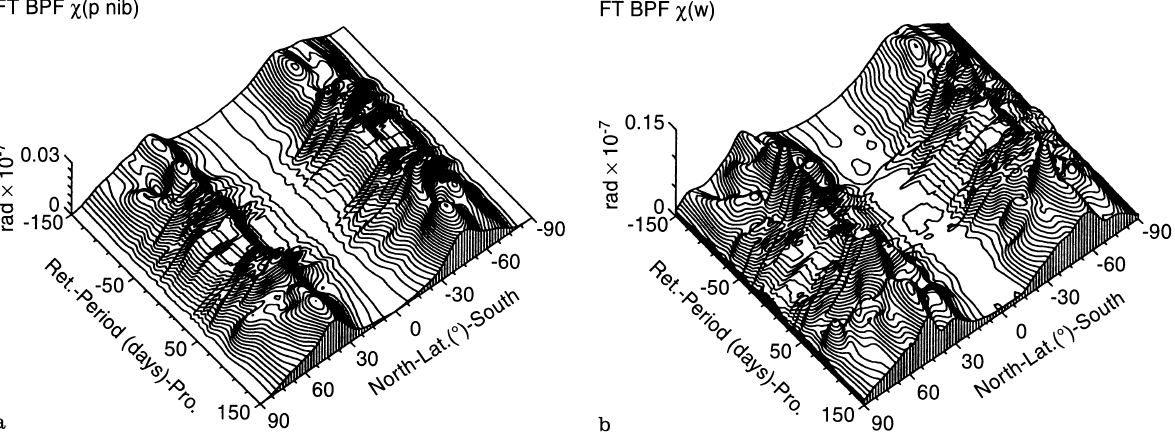
Fig. 2 a, b. Examples of variations of the pressure and wind terms of the (cid:118) latitude belts of about 2 : (cid:14) width each; a pressure terms, b wind terms